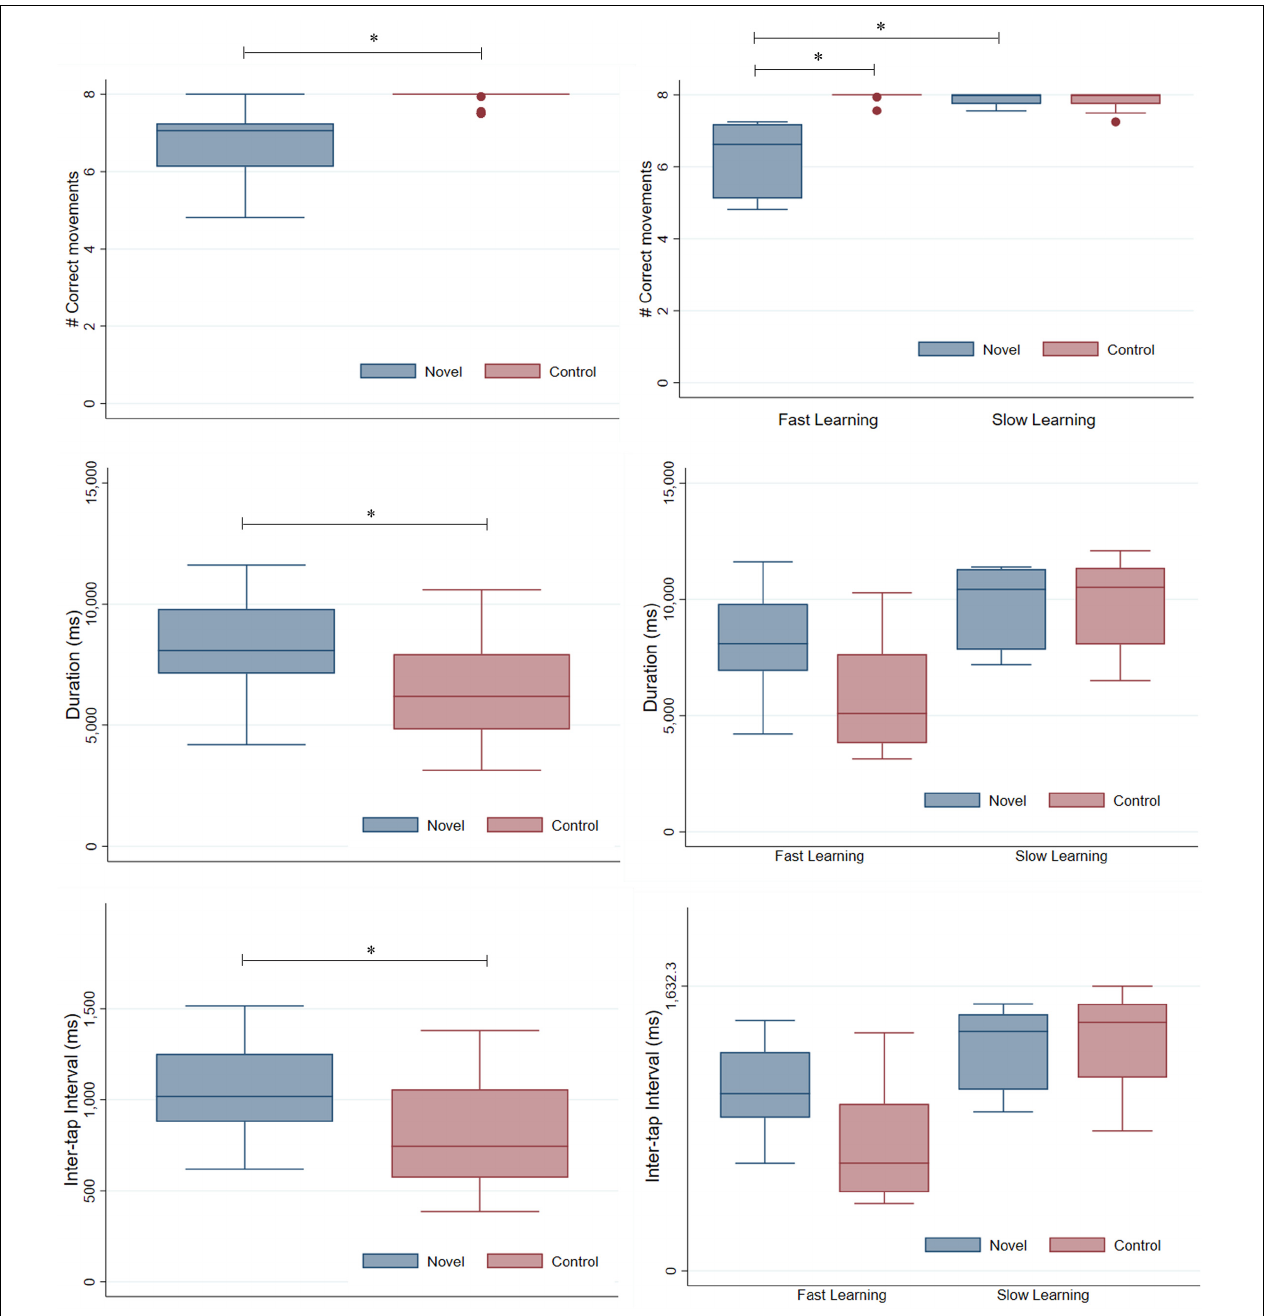
FIGURE 1 | Box-plots for accuracy (i.e., average number of correct movements per sequence along the scanning session), duration and inter-tap intervals. The maximum number of correct movements which could be executed per sequence was 8, the maximum duration for motor execution was 12,500 ms and interstimulus interval during visual presentation was of 1,500 ms. (Left) Number of correct movements (Top row) , duration (Middle row) , and inter-tap interval (Bottom row) during FL in sample from Study 1 ( n = 25). Different boxes are represented for novel and control sequences. (Right) Number of correct movements (Top row) , duration (Middle row) and inter-tap interval (Bottom row) during FL and SL in sample from Study 2 ( n = 11). Different boxes are represented for every task (novel and control) and learning phase (FL and SL). ∗ Indicates significant differences with p -values < 0.01 in every case.